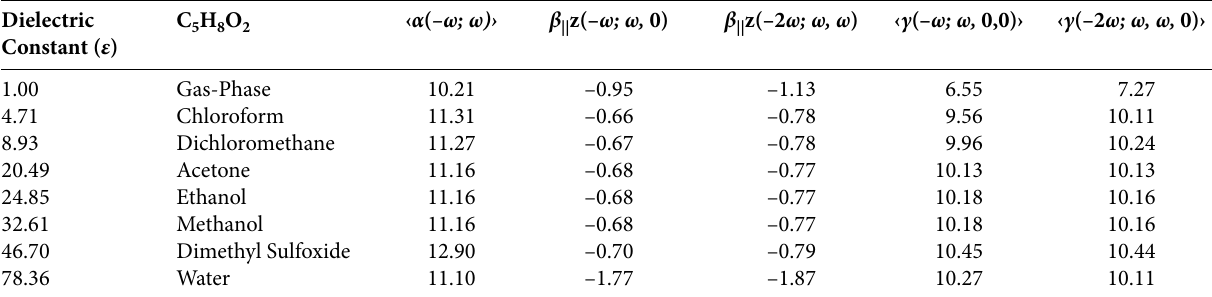
Table 5: PCM-CAM-B3LYP/6-311++G(d,p) results for the dynamic linear polarizability (in 10 –24 esu ), first hyperpolarizability (in 10 –30 esu) and second hyperpolarizability (in 10 –36 esu) of C 5 H 8 O 2 in various solvent media for the frequency ω = 0.0428 a.u. Dielectric